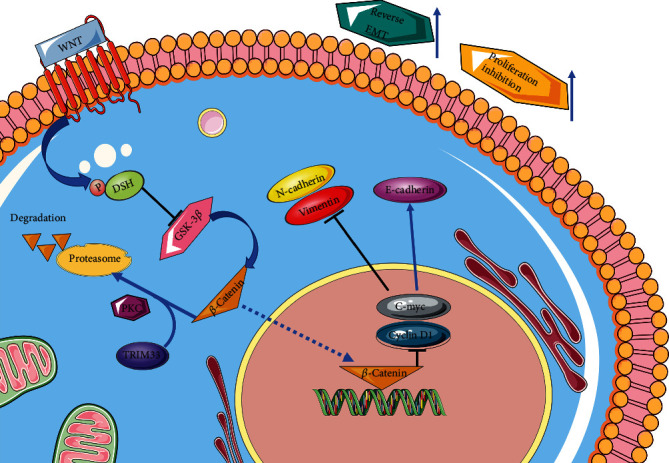
Schematic diagram of TRIM33 affecting renal cancer cell proliferation and EMT through the Wnt/β-catenin pathway (requires further experimental proof).